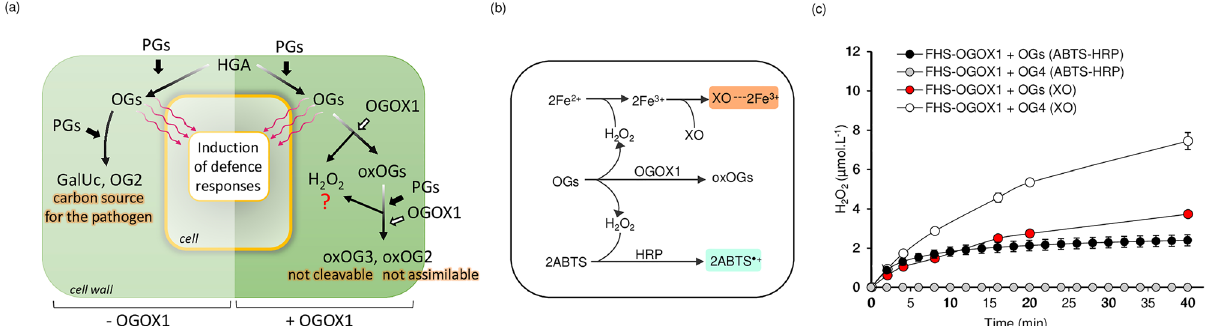
Figure 1. OGOX1 oxidizes galacturonan oligomers and concomitantly releases H 2 O 2 . ( a ) Potential roles of OGOX1 in plant defense: without OGOX1, PGs degrade HGA into OGs and then into OG2 and GalUc, useful carbon source for the fungus. In the presence of OGOX1, the reducing ends generated by PG activity are oxidized by OGOX1 and H 2 O 2 is produced. The degradation products resulting from the concomitant activity of PG and OGOX1 are oxOG3 (not further cleavable by endoPGs) and oxOG2 (not assimilable by the fungal pathogen Botrytis cinerea ). The scheme is based on the results reported in Benedetti et al. 6 . ( b ) Simplified scheme showing the reactions of (up) the xylenol orange (XO) and (down) ABTS-HRP coupled assays used for the kinetic measurements of OGOX1 using OGs as substrate. ( c ) Production of H 2 O 2 (µmoles.L −1 ) over time at pH 5.0 by the activity of FHS-OGOX1 (4 nM) using equimolar amounts (15 µM) of OGs and OG4 by xylenol orange (XO) and ABTS-HRP coupled assay (ABTS-HRP). For the ABTS-HRP assay, the reaction mixture also included ABTS (100 µM) and HRP (0.05 g.L −1 ). Values are mean ± SD (N = 3). [ ABTS